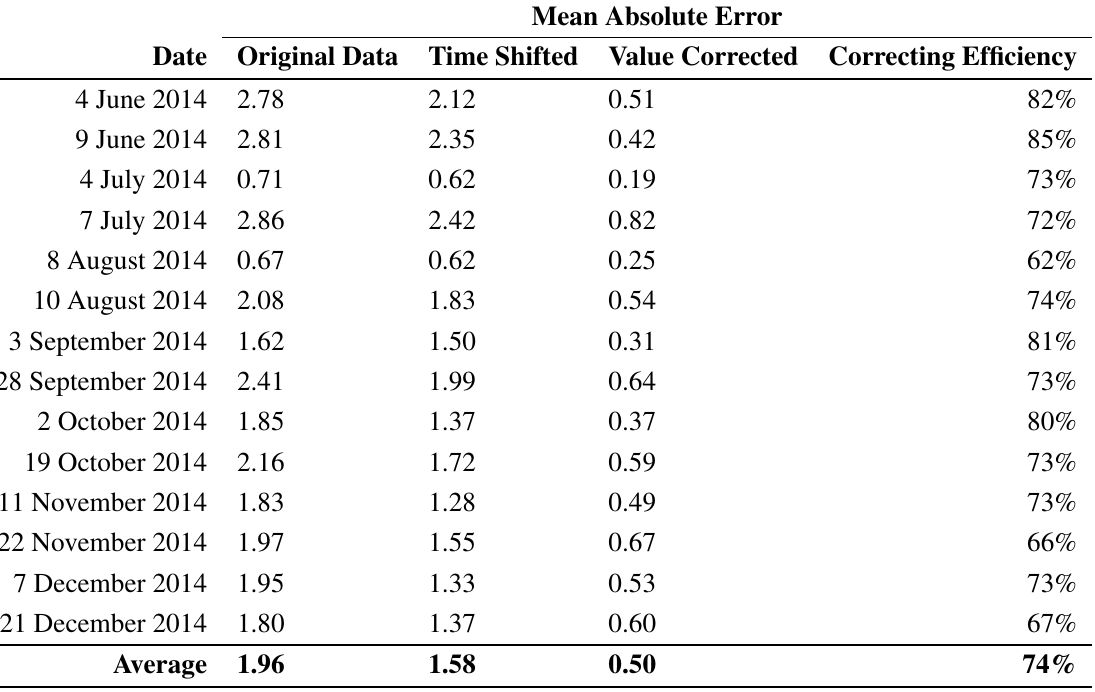
Table 4. Mean absolute error in different correcting